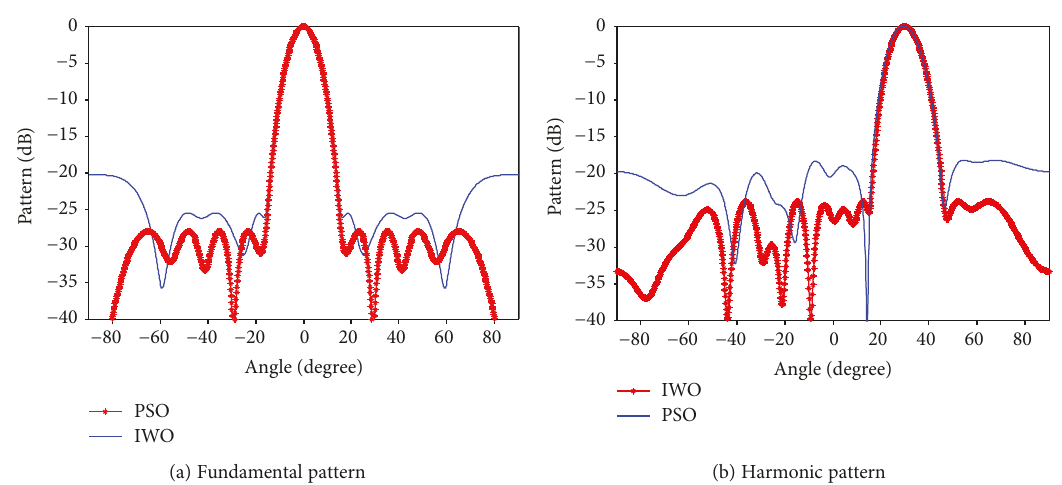
Figure 5: Rational patterns obtained by the IWO and PSO algorithms.